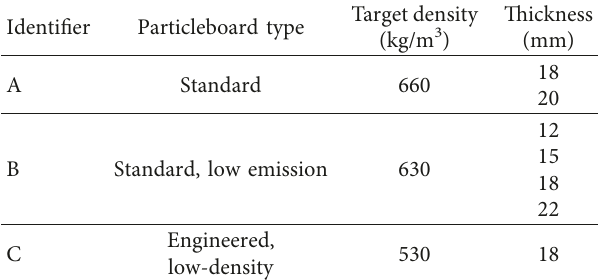
Table 1: Information on the particleboard types used in the study.